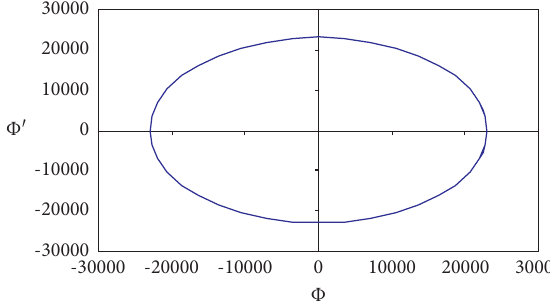
Figure 25: The stability phrase Φ ′ and Φ for case (ii) in Section 4.2.